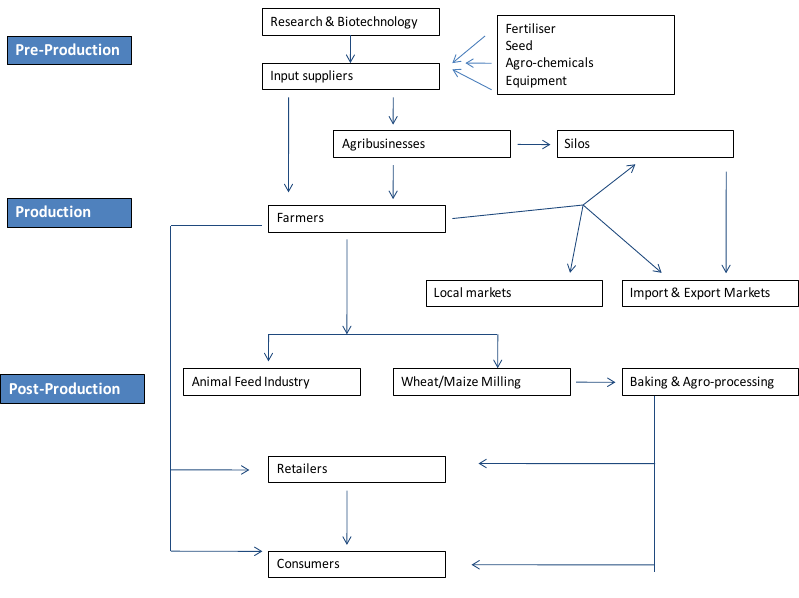
FIGURE 2: Diagrammatic representation of the South African agri-food value chain Source: Adapted from Louw, Geyser, Trotskie, Van der Merwe, Scheltema and